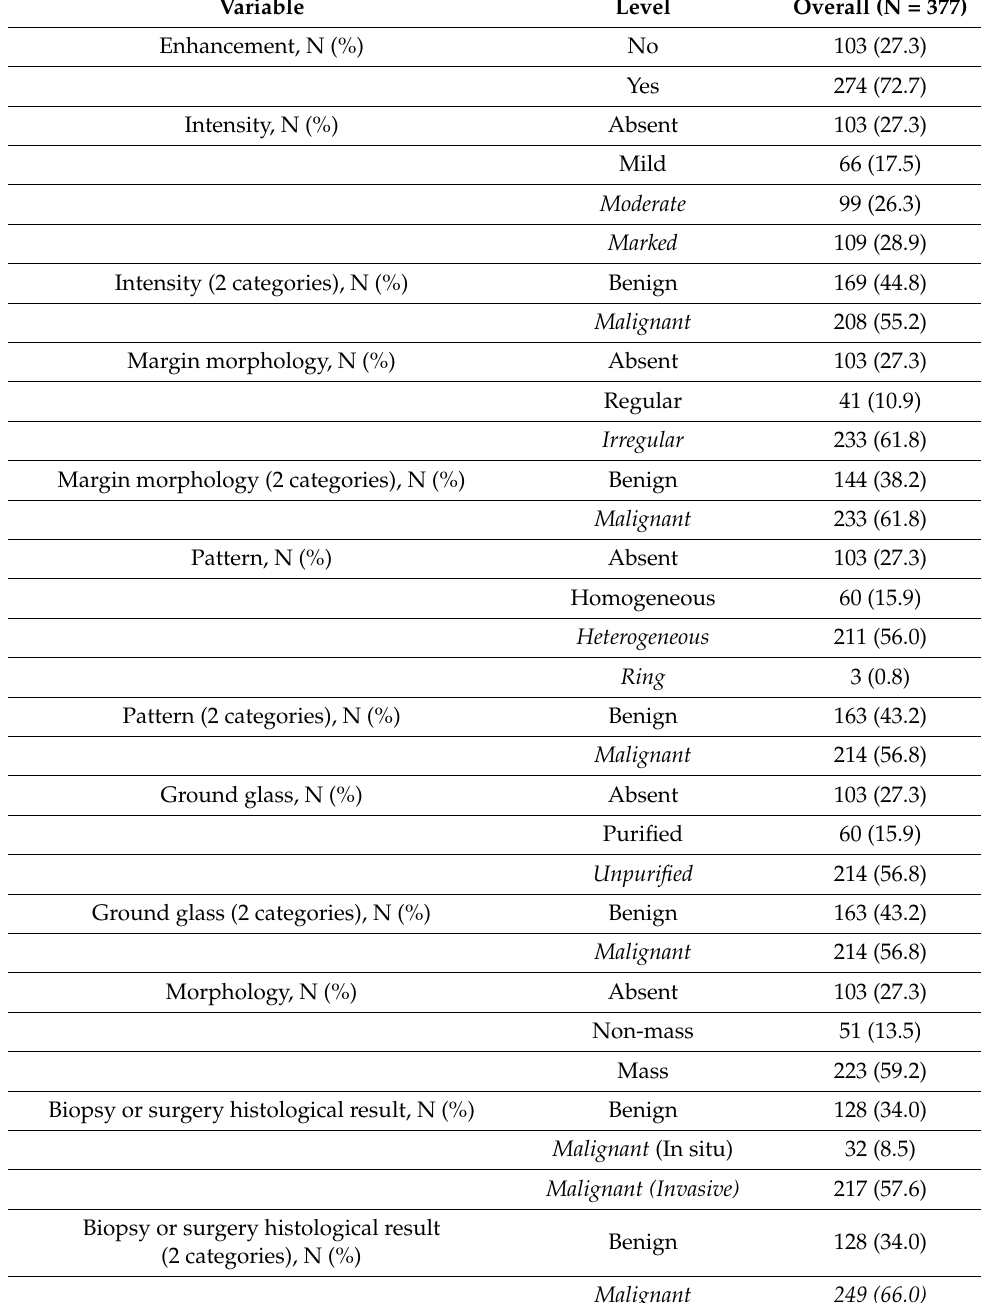
Table 2. Distribution of the different enhancements and histological result (gold standard) (N =